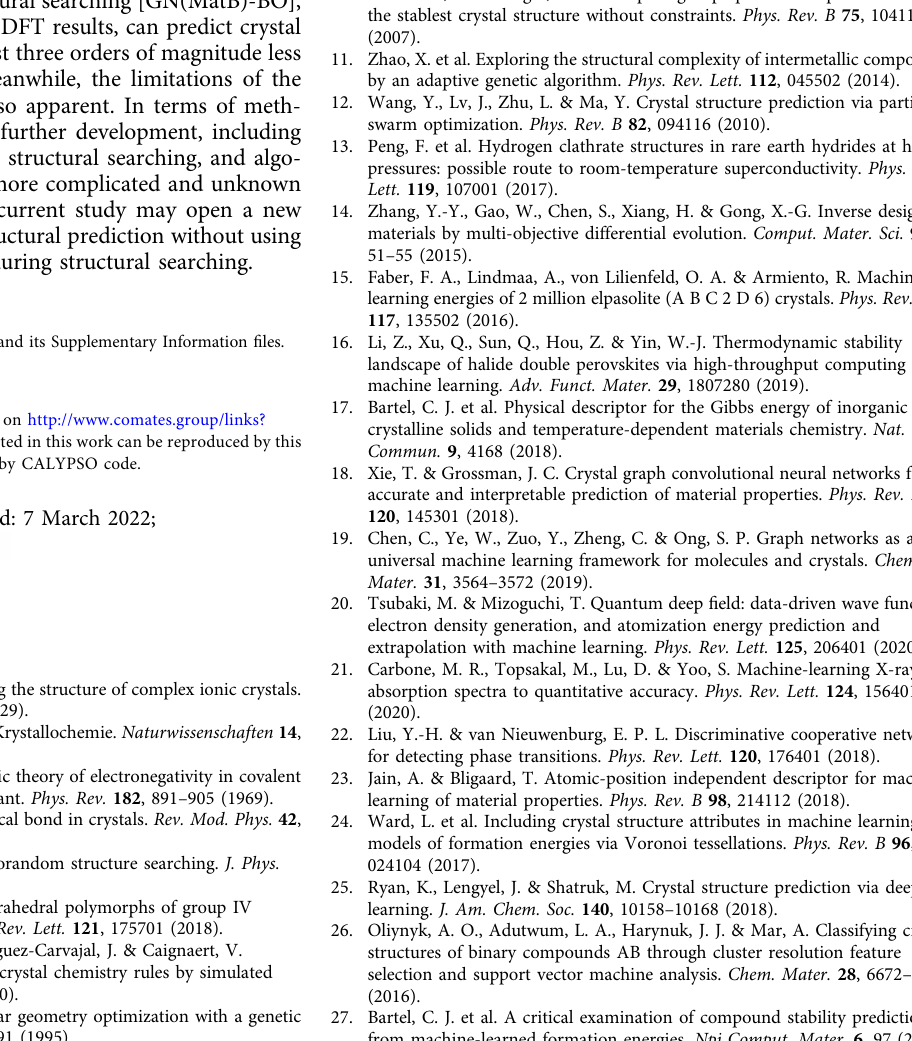
Fig. 5 The comparison of computational cost. The computational cost of GN(MatB)-BO and DFT-PSO to fi nd the right crystal structures. The computational time is accounted for running on CPU core [Intel(R) Xeon(R) Silver 4210 CPU @